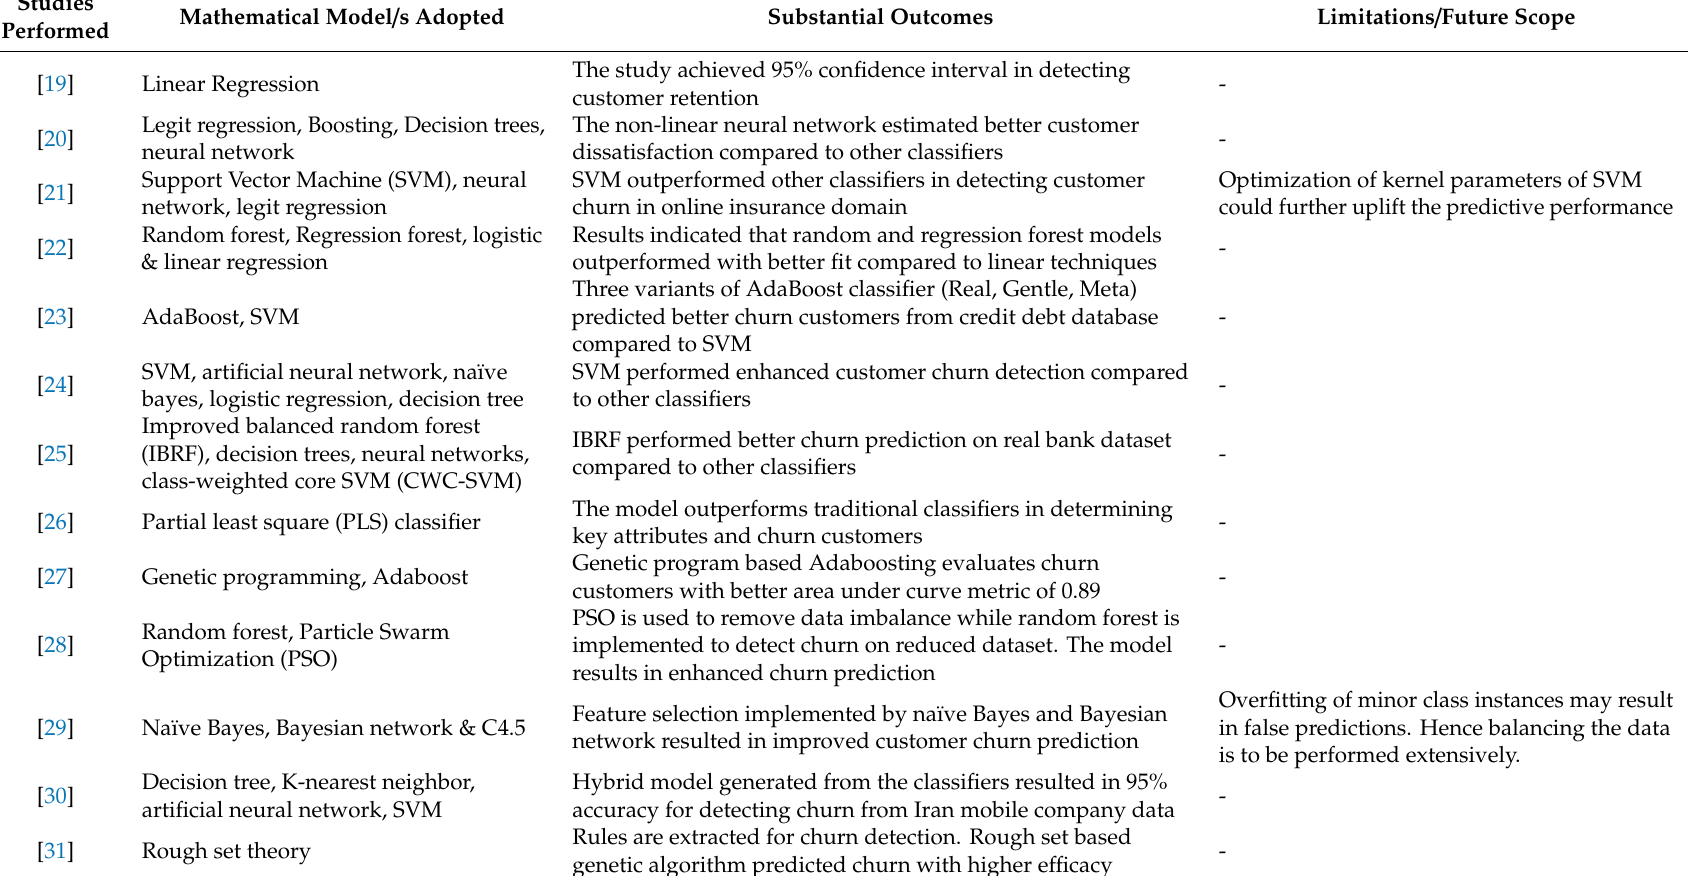
Table 1. List of substantial churn detection